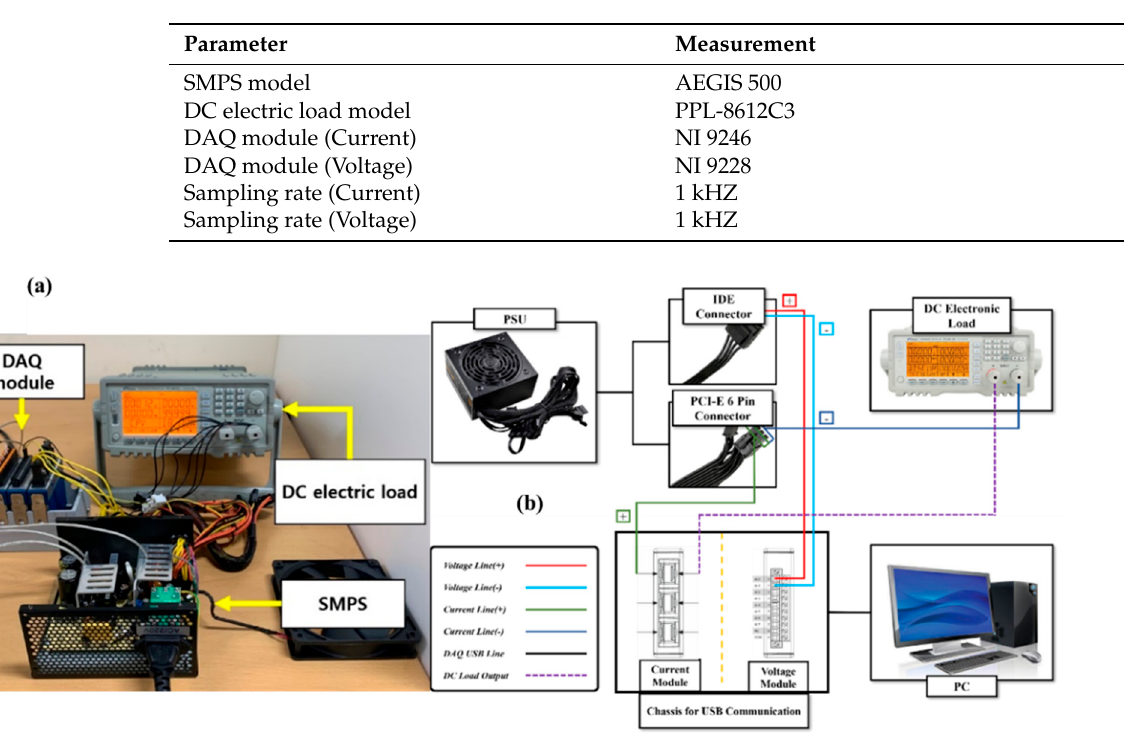
Figure 5. Experimental Test Bench ( a ) Actual view of Test Bench ( b ) Test Bench Component Con- nection.